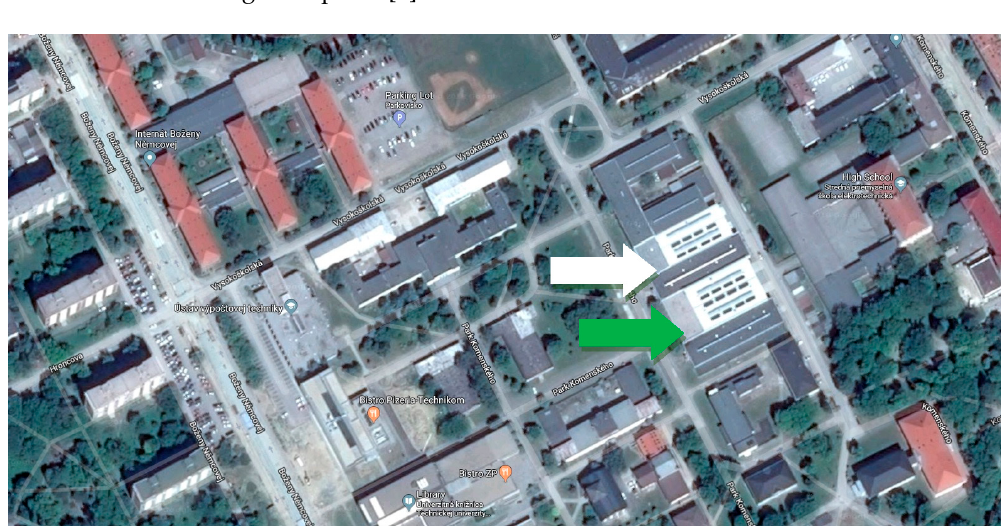
Figure 1. Campus of Technical University; Green arrow-building with the green wall in the entrance hall; White arrow-building without the green wall in the entrance hall.